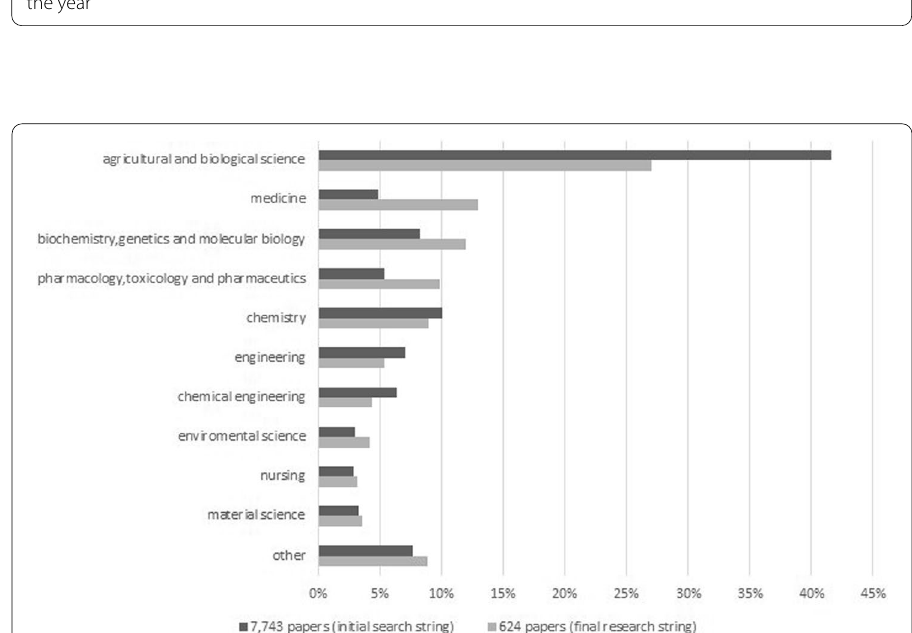
Fig. 5 Publications by subject area. Note: for each category, the bars above refer to the total number of papers (i.e. 7743 derived from the initial search string), while the bars below refer to the selected papers (i.e. 624 derived from the final search